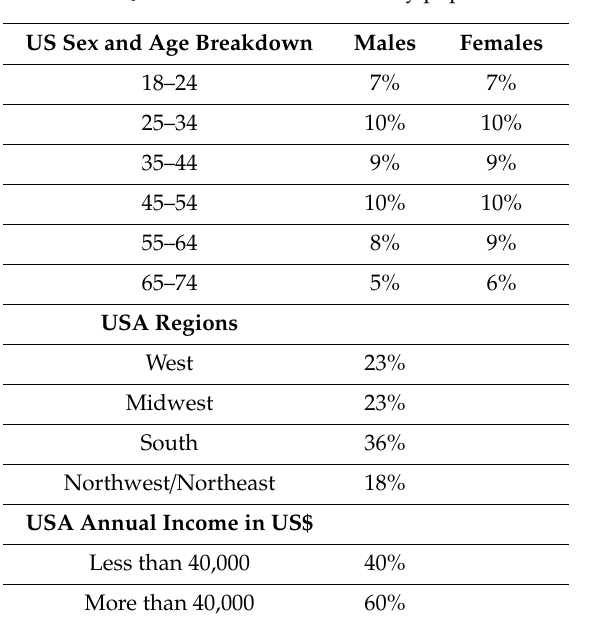
Table 1. Quota used to select the study